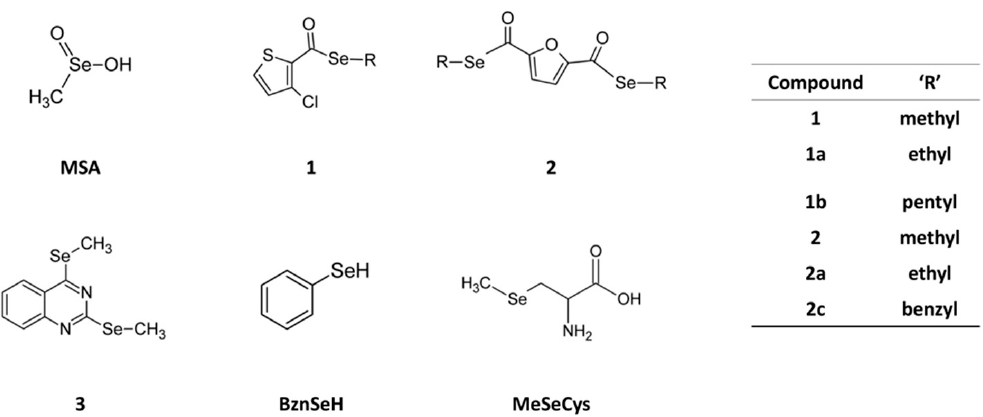
Figure 1. Chemical structures of the compounds. MSA, and compounds 1 and 2 were the primary focus of this study, whereas remaining compounds were used for comparative analysis in some experiments. MSA: methylseleninic acid; R: substituent; BznSeH: benzeneselenol; MeSeCys: methylselenocysteine.